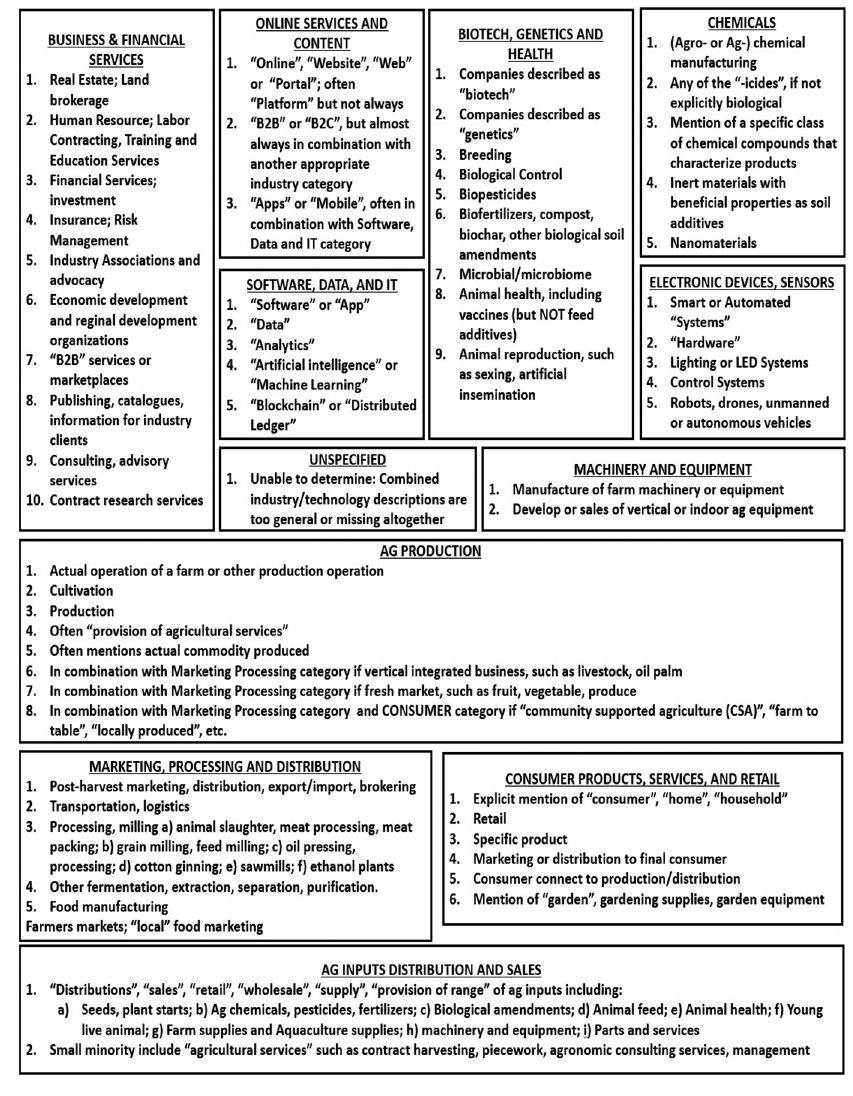
Figure 2. Agtech classi fi cation model proposed by Graff et al.